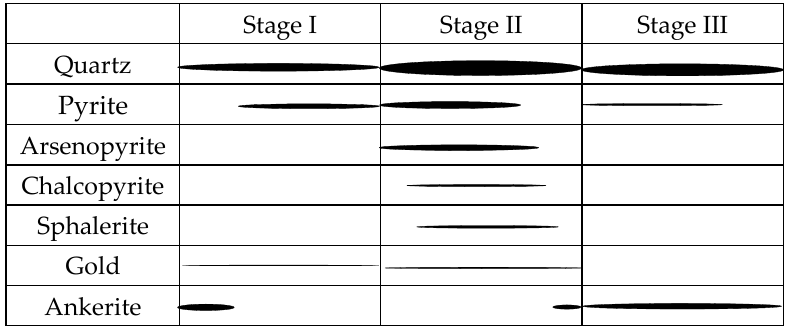
Table 1. Analyses and sampling localities.